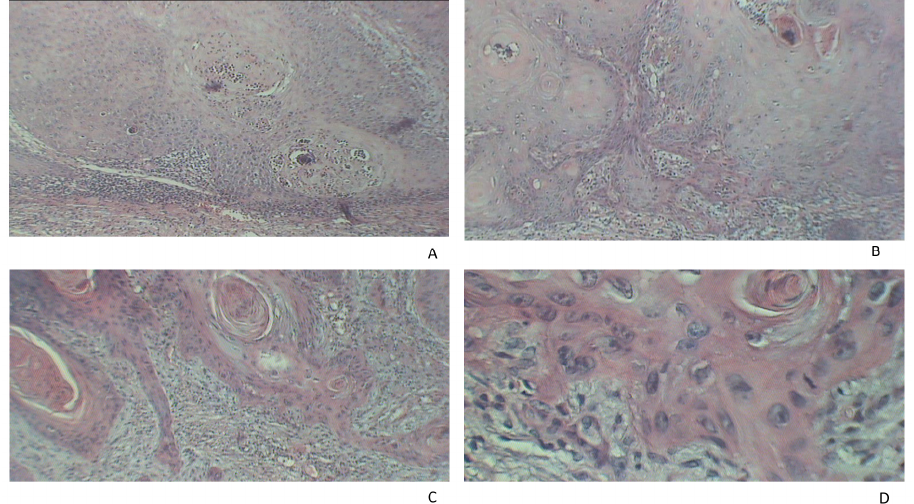
Figure 1. Histopathological examination of cSCC. ( A ) Cell proliferation with giant nuclei and nuclear polymorphism (HE, × 40). ( B ) Proliferation of squamous cells which extend into the deeper layers of the skin, abundant inflammatory infiltrate (HE, × 40). ( C ) Massive inflammatory infiltrate distributed throughout the tumor mass and disseminated tumor cells with giant nuclei (HE, × 40). ( D ) Proliferation of squamous cells with nuclear pleomorphism and nuclear abnormalities and abundant inflammatory infiltrate (HE, ×